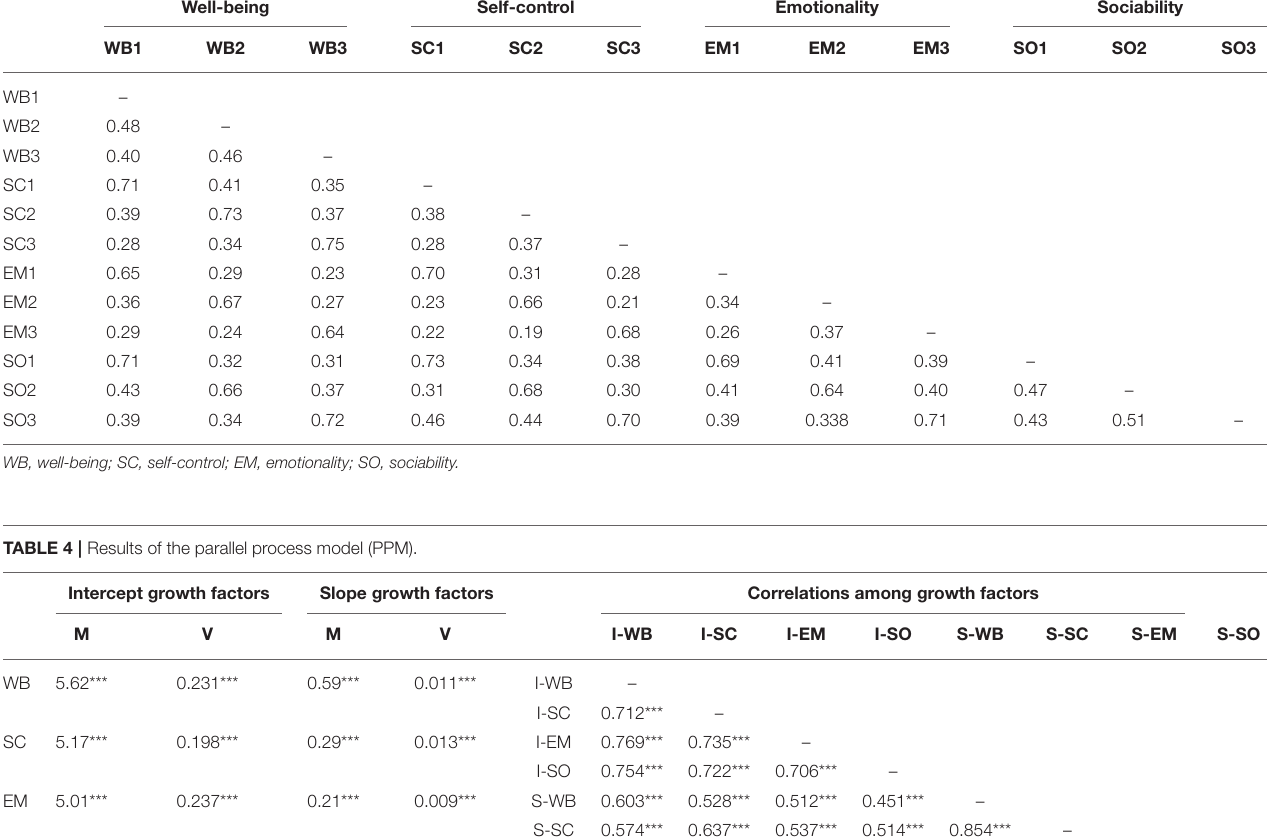
TABLE 3 | Correlation matrix between subdomains. Well-being